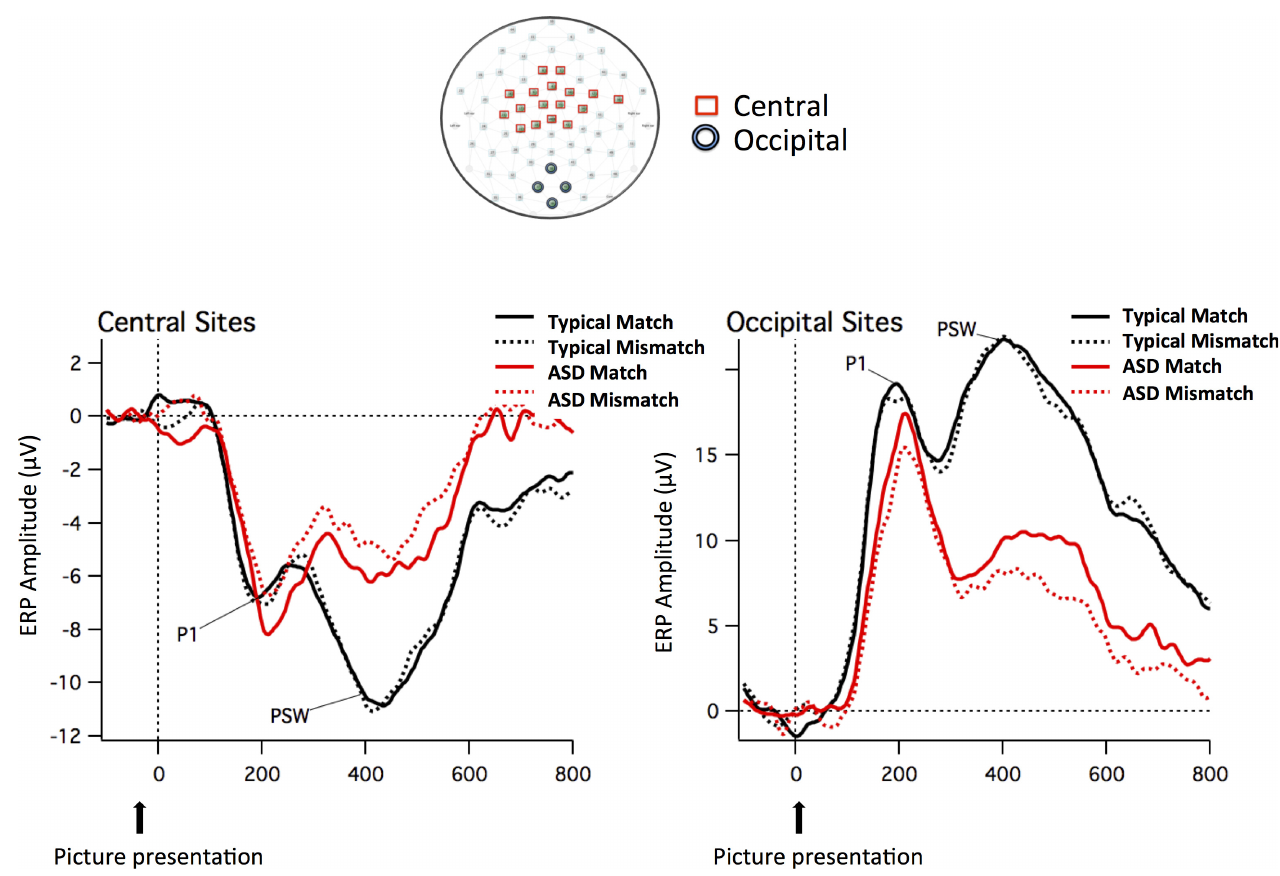
Fig 4. ERP waveforms of visual evoked potentials. ERP waveforms time-locked to the picture for the two groups (Neurotypical and ASD children) and the two conditions (Match and Mismatch) in the mean channels relative to the Central and Occipital sites included in the arrays. The sites that were used to create these arrays are displayed in the topographical map (Central sites in red and Occipital sites in green).